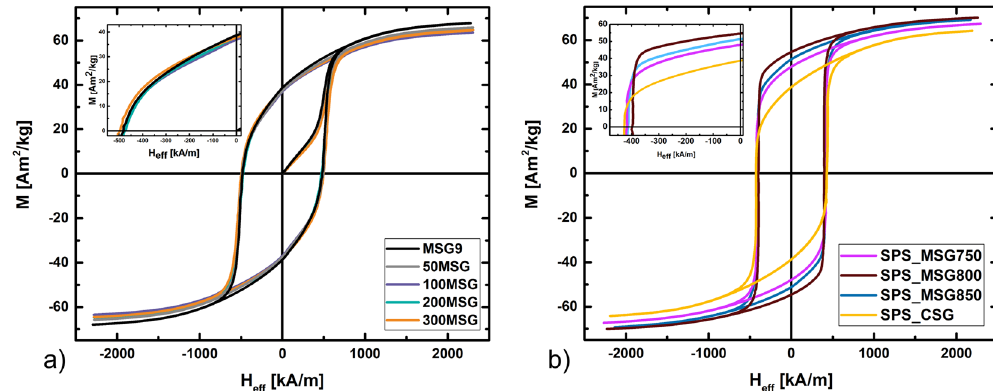
Figure 6. ( a ) Hysteresis curves of MSG samples added between 50 and 300% extra NaCl relative to the precursor. ( b ) Hysteresis curves SPS compacted pellets made from CSG or MSG synthesised powder.